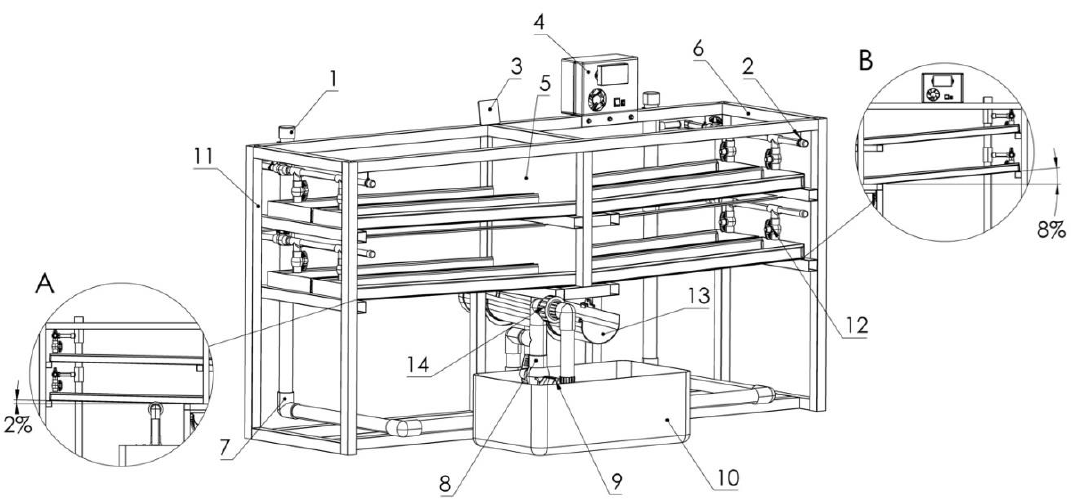
Figure 1. Hydroponic fodder growing stand scheme: ( A ) trays sloped at 2.0% and ( B ) trays sloped at 8.0%; 1—blind, 2—pipe holder, 3—temperature and humidity meter, 4—light-emitting diode (LED) controller, 5—organic glass, 6—aluminum profile frame, 7— polyvinyl chloride (PVC) elbow, 8—total